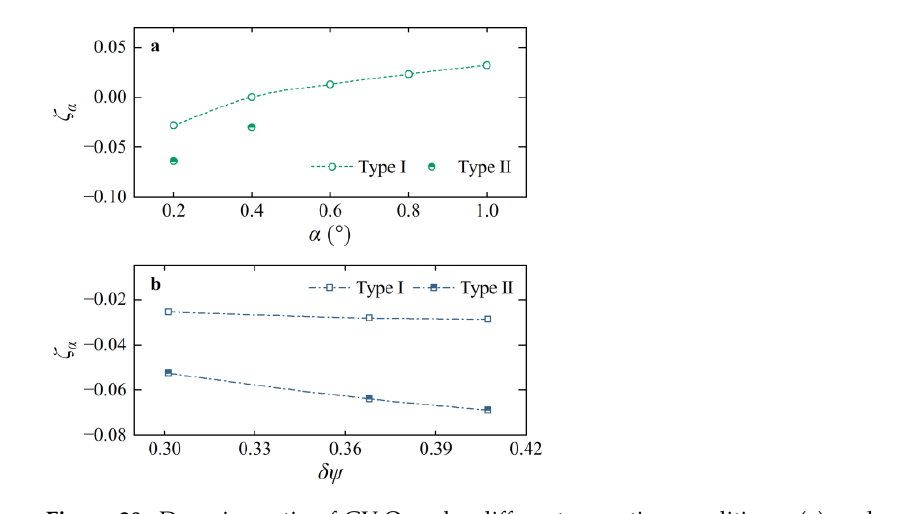
Figure 20. Damping ratio of GV-O under different operating conditions: ( a ) under different GV opening angles with the head coefficient of C ψ = 1.133; ( b ) under different pressure differences between the GV inlet and outlet.